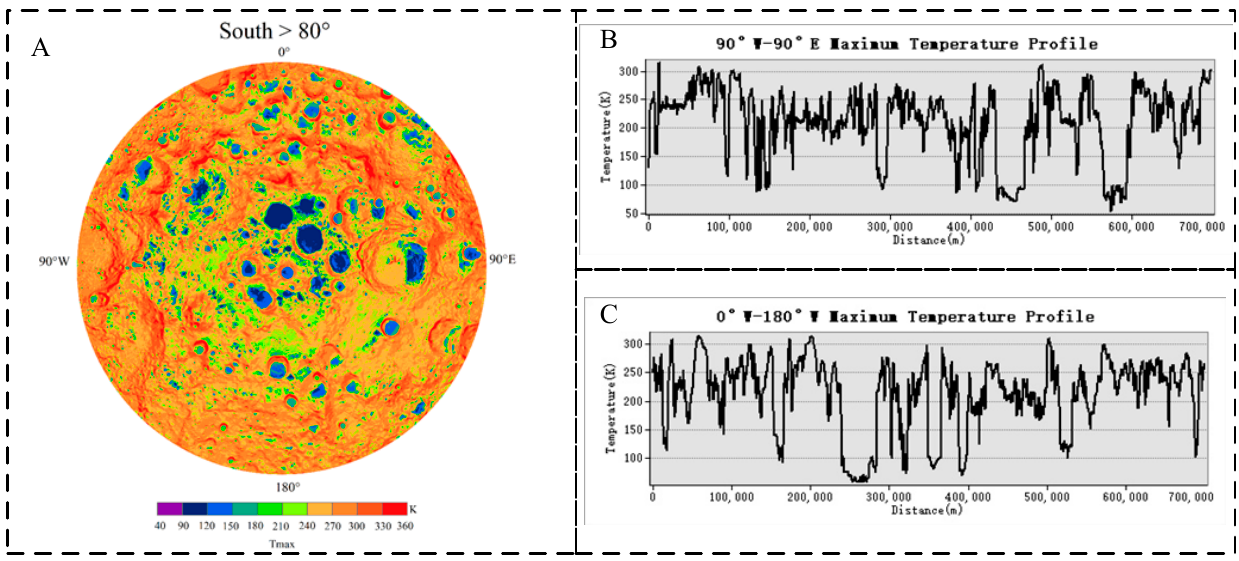
Figure 15. Analysis of maximum temperatures at the south pole of the Moon. Map of maximum temperature profiles: ( A ) south pole; ( B ) 90°W–90°E; ( C ) 0°W–180°W. temperature profiles: ( A ) south pole; ( B ) 90 ◦ W–90 ◦ E; ( C ) 0 ◦ W–180 ◦